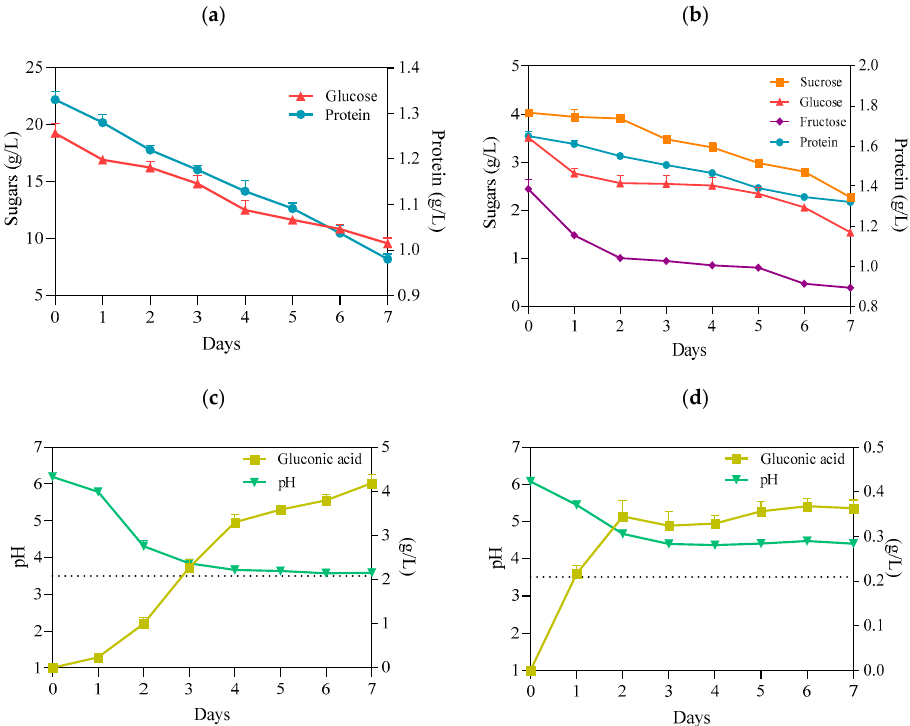
Figure 2. ( a ) Concentration of glucose and protein in HS medium; ( b ) concentration of sugars and protein in PJ medium; ( c ) pH and gluconic acid concentration in HS medium; ( d ) pH and gluconic acid concentration in PJ medium—all before and during BC biosynthesis by K. xylinus ATCC 53524. Data are presented as a mean ± standard error of the mean (SEM). critical pH value (3.5).